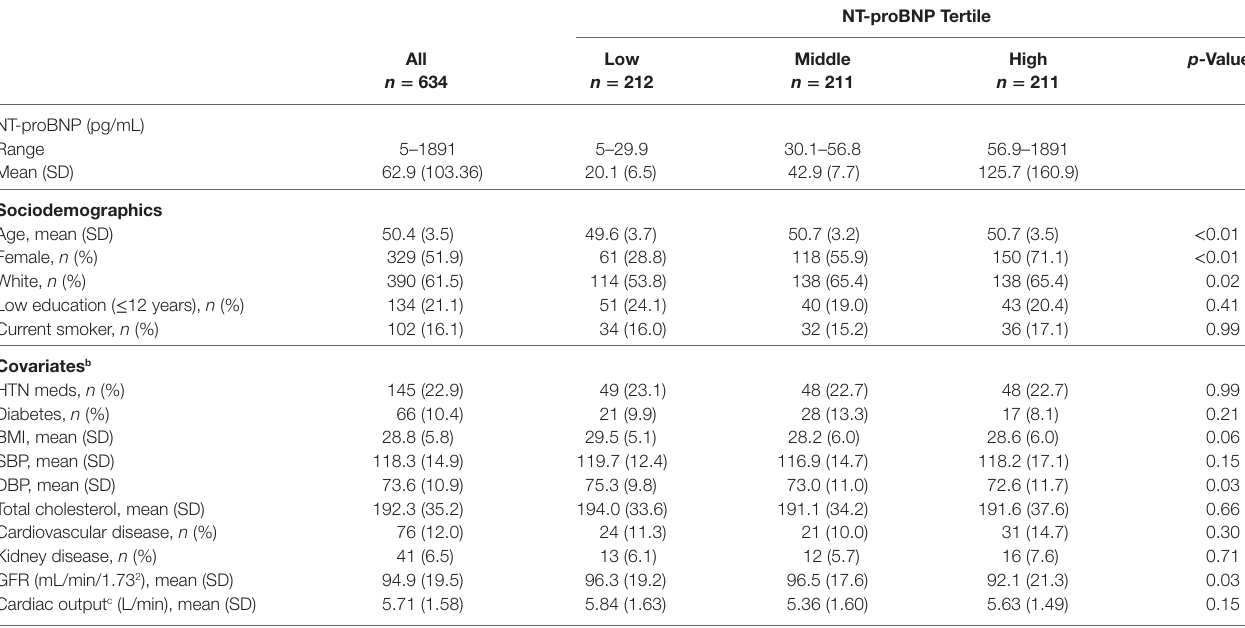
TaBle 1 | Characteristics a of the CARDIA brain magnetic resonance imaging sample (2010–2011) according to N-terminal pro-brain natriuretic peptide (NT-proBNP) tertile.